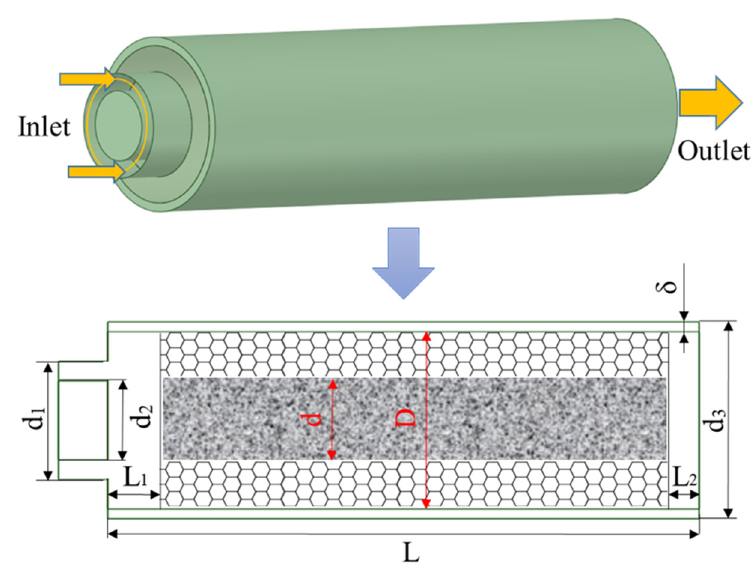
Figure 1. Schematic diagram of geometric structure.